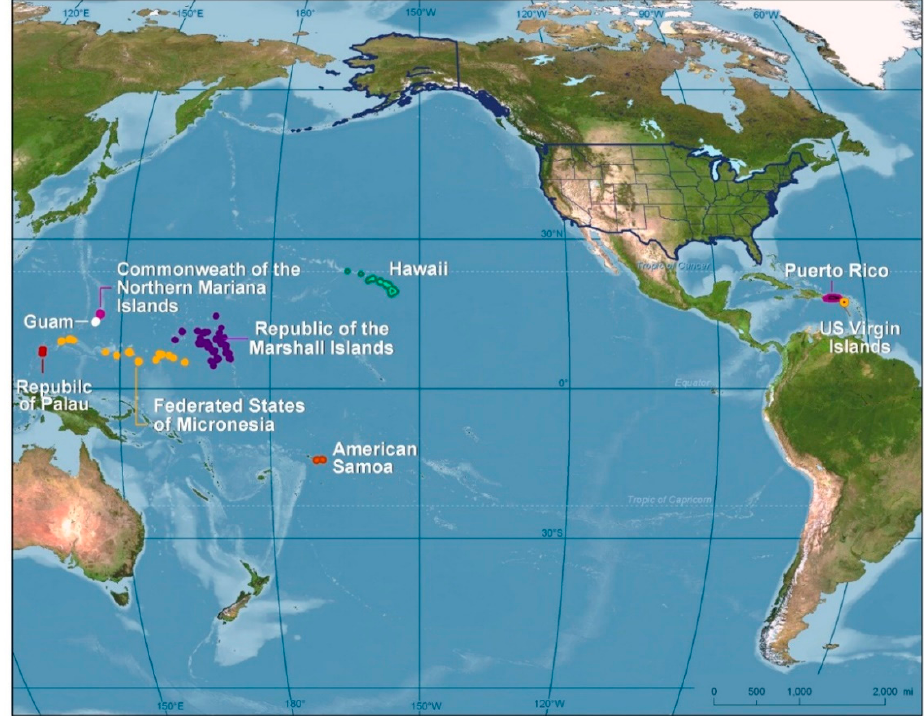
Figure 1. Location of the nine island jurisdictions encompassing the study area.